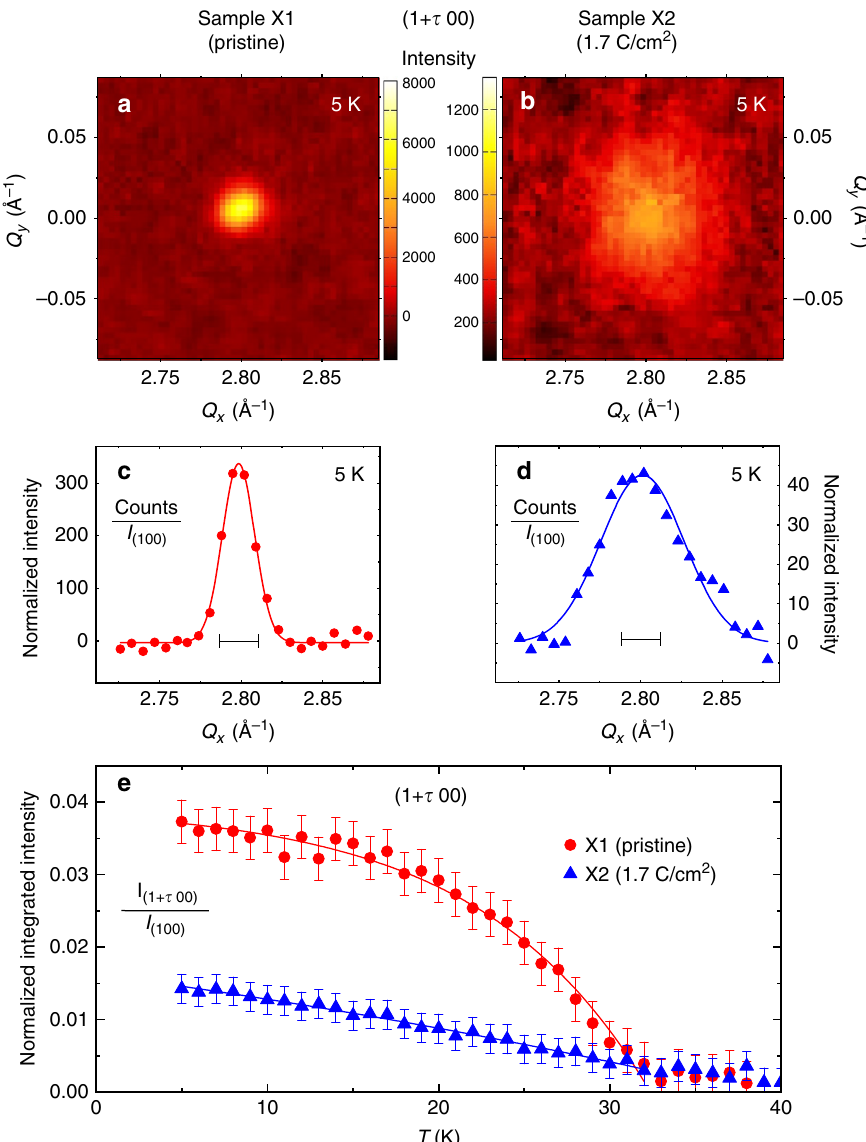
Fig. 5 High-energy X-ray diffraction measurement of the CDW Bragg peak (1 + τ 0 0) with τ = 1/3. Results of two NbSe 2 samples (X1: pristine, X2: 1.7Ccm − 2 ). a , b Diffraction patterns of X1 and X2 recorded by the two-dimensional detector in the ( H K 0) plane with intensity encoded in a linear color scale for each detector pixel. c , d Cuts along the longitudinal direction Q x , integrated along the transverse direction Q y and normalized to the integrated intensity I (100) of the weak (100) Bragg peak of the regular chemical lattice which is three orders of magnitude less intense than the strong (110) Bragg peak. The bars represent the instrumental resolution full-width half-maximum determined from the (100) Bragg peak. e Temperature dependence of the normalized integrated intensity of the CDW Bragg